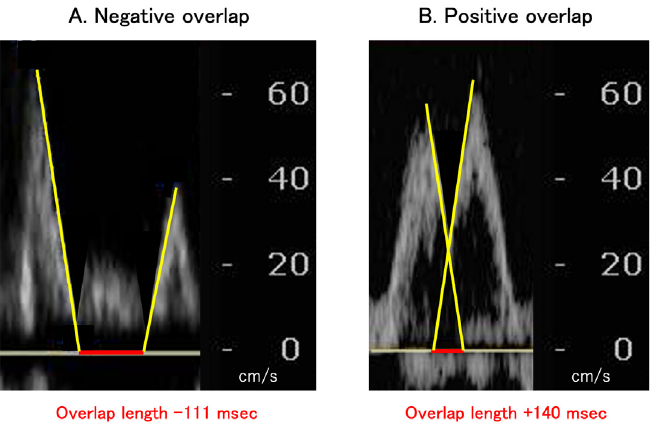
Figure 1. Examples of a case with negative overlap ( A ) and a case with positive overlap ( B ). In the case of A, a patient had an HR of 60 bpm and a deceleration time of 137 msec. E-wave and A-wave did not overlap. In the case of B, another patient had an HR of 131 bpm and a deceleration time of 160 msec. E-wave and A-wave considerably overlapped.